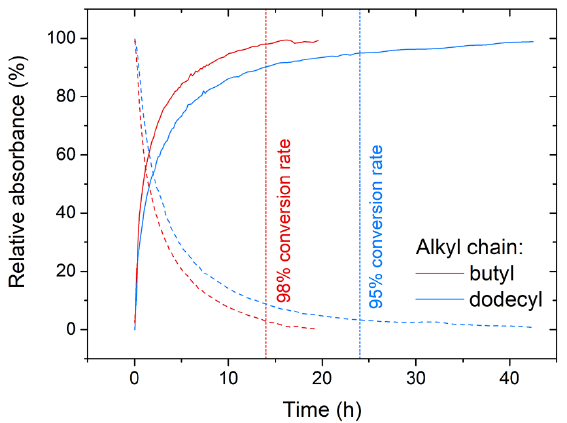
Figure 1. Kinetic curves for quaternizations with potassium chloroacetate; solid line: product (alkyldimethylglycine zwitterion), dashed line: substrate (alkyldimethylamine).